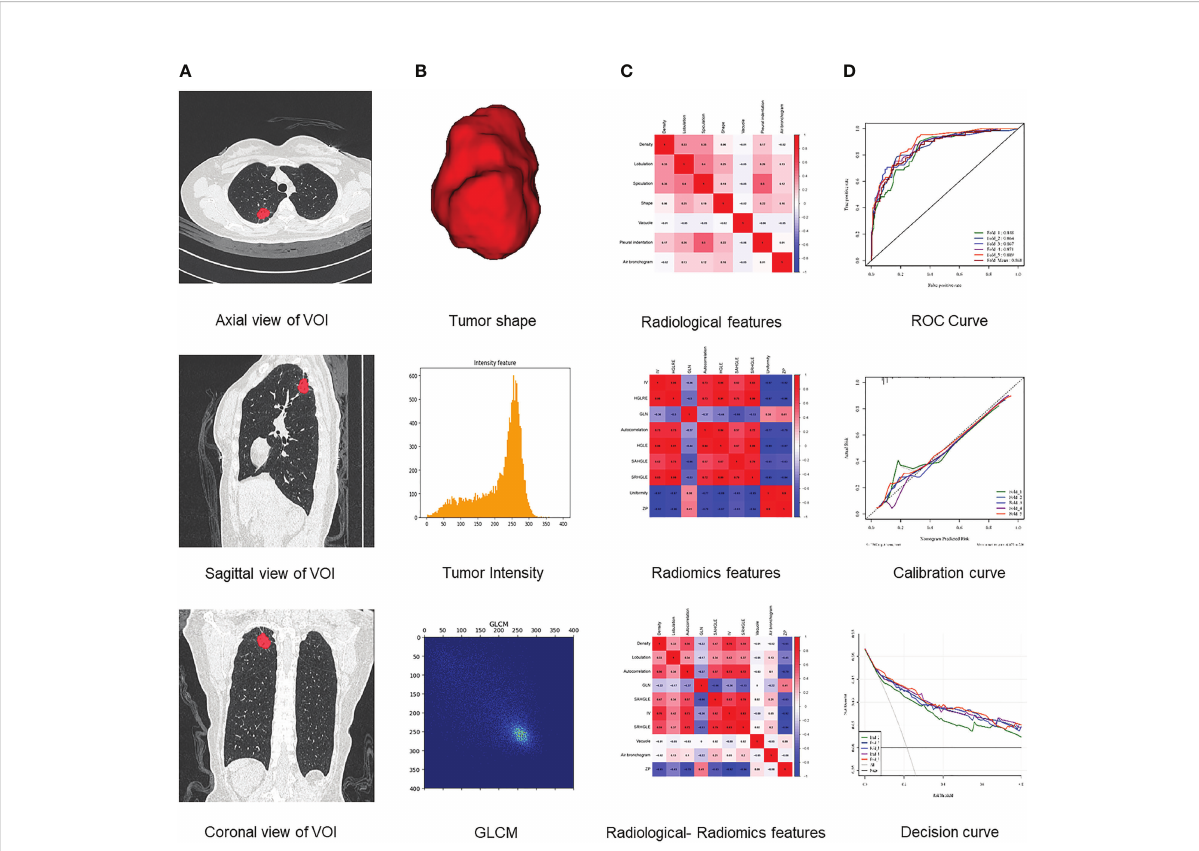
FIGURE 2 Flowchart of radiomics analysis. (A) Platform built-in lung nodule detection and segmentation model for automatic annotation of lung nodule VOI. (B) Features extracted from VOI, including tumor shape, intensity, and texture features. (C) Analysis of radiological, radiomics, and radiological-radiomics features. (D) Model establishment and